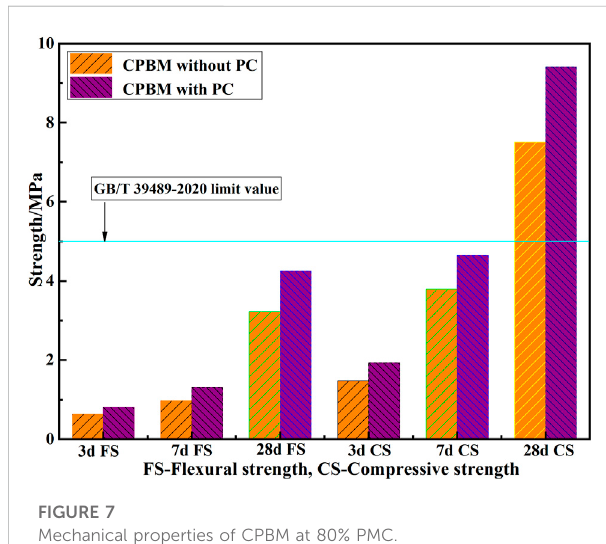
FIGURE 7 Mechanical properties of CPBM at 80%